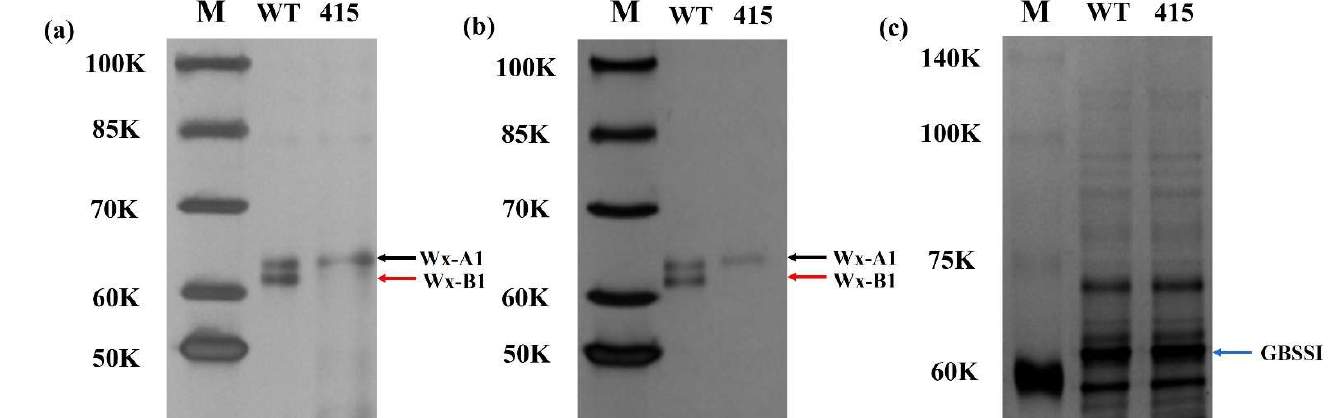
Figure 1. Profiles of the Wx proteins and total grain proteins obtained via SDS-PAGE. Wx-A1 and Wx-B1 proteins in mature ( a ) and developing ( b ) grains are represented by black and red arrows. The total grain proteins ( c ) were extracted from the WT and mutant 415. lines, the blue arrow represents GBSSI protein in both lines.